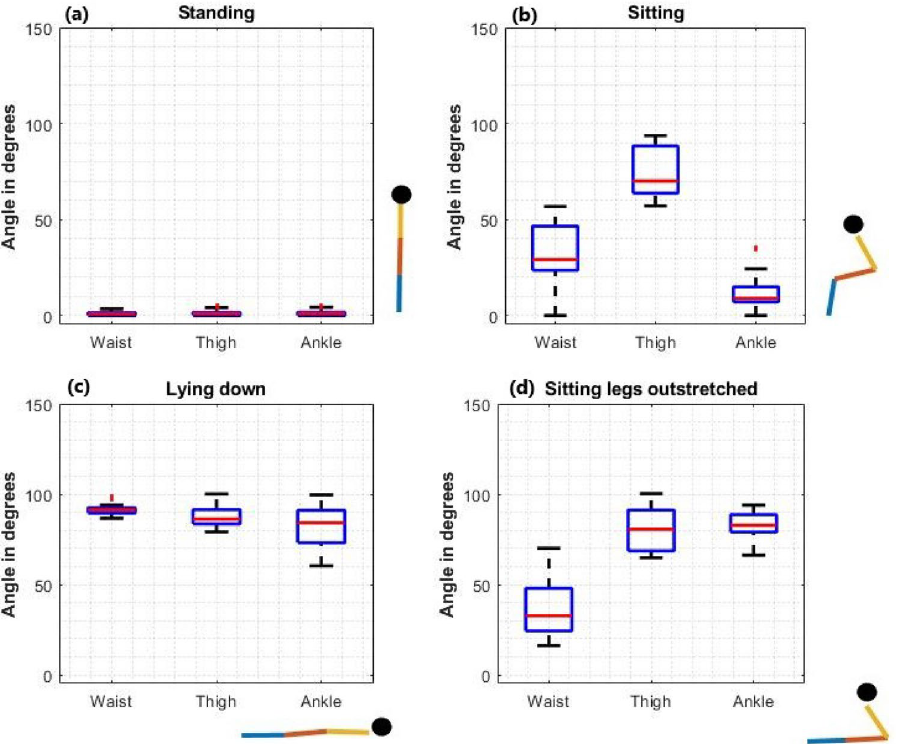
Figure 4. Inclination angles for the waist, thigh, and ankle from all 15 datasets for ( a ) standing, ( b ) sitting, ( c ) lying down, and ( d ) sitting with legs outstretched. The stick figures are drawn using the median value of the inclination